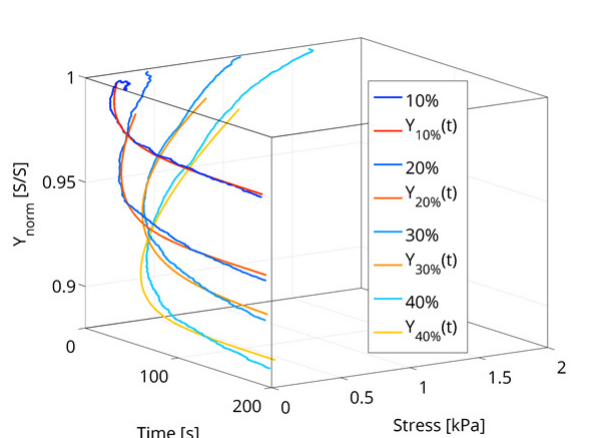
Fig. 12. Admittance vs. stress vs. time for each strain level and portions of their corresponding relaxation curves. Though the fit is not perfect, it is an appropriate first approximation that yields a high level of correlation ( R 2 > 0.95 in all